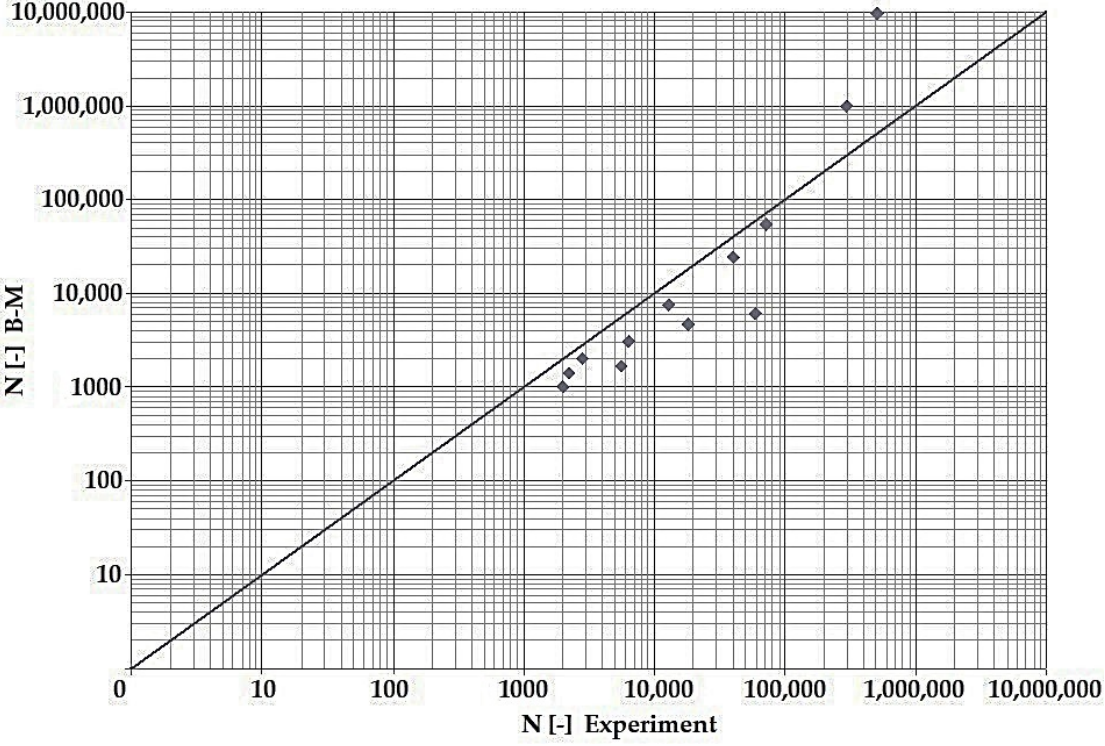
Figure 21. Dependence of theoretical and experimentally obtained number of cycles, Brown–Miller vs. experiment, phase shift 0°.